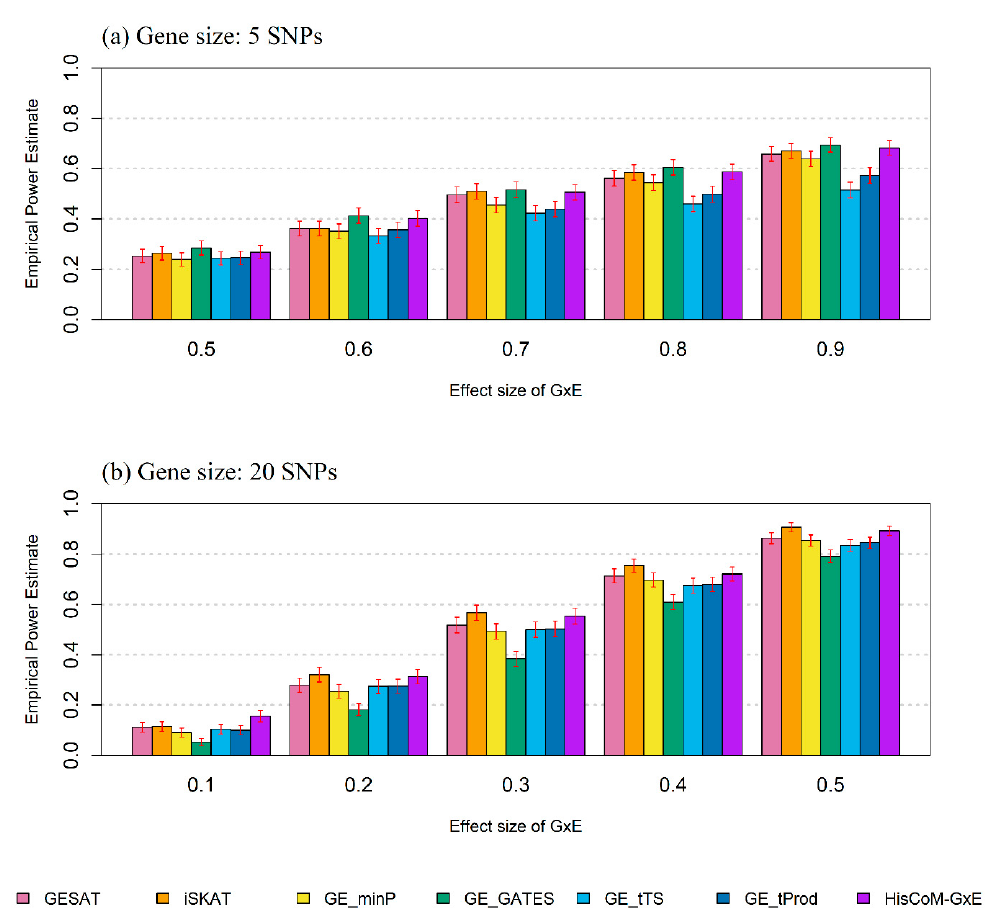
Figure 1. Empirical power estimates as e ff ect size of G × E when the gene sizes are ( a ) 5 SNPs and ( b ) 20 SNPs. The empirical power estimates were calculated with 1000 replicates. Results for each method can be distinguished by plotting colors. Each bar is the mean and the error bars represent standard deviation (SD).